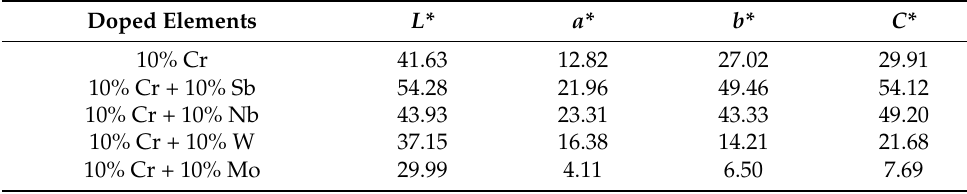
Table 4. Chromatic parameters of colored glazes with the doped TiO 2